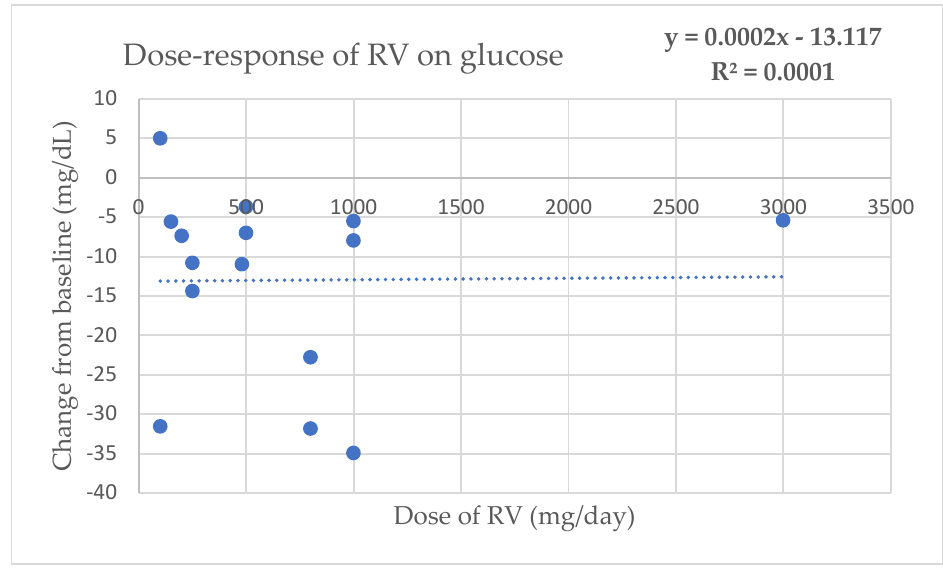
Figure A1. Dose–response regression analysis to assess the effect of RV on serum glucose levels.